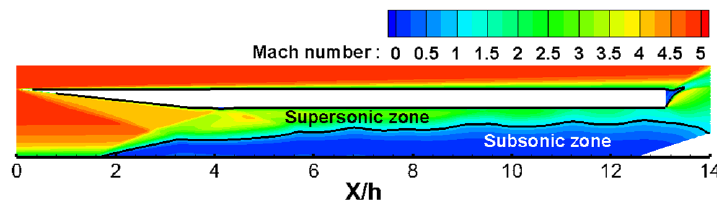
Figure 4. Mach number contours for the flap angle of 18° at time = 0.05 s. Since the flap angle of 19 ◦ shows HAO mode and the flap angle of 18 ◦ shows a transitional state between NO mode and the inlet start state, it is expected that a